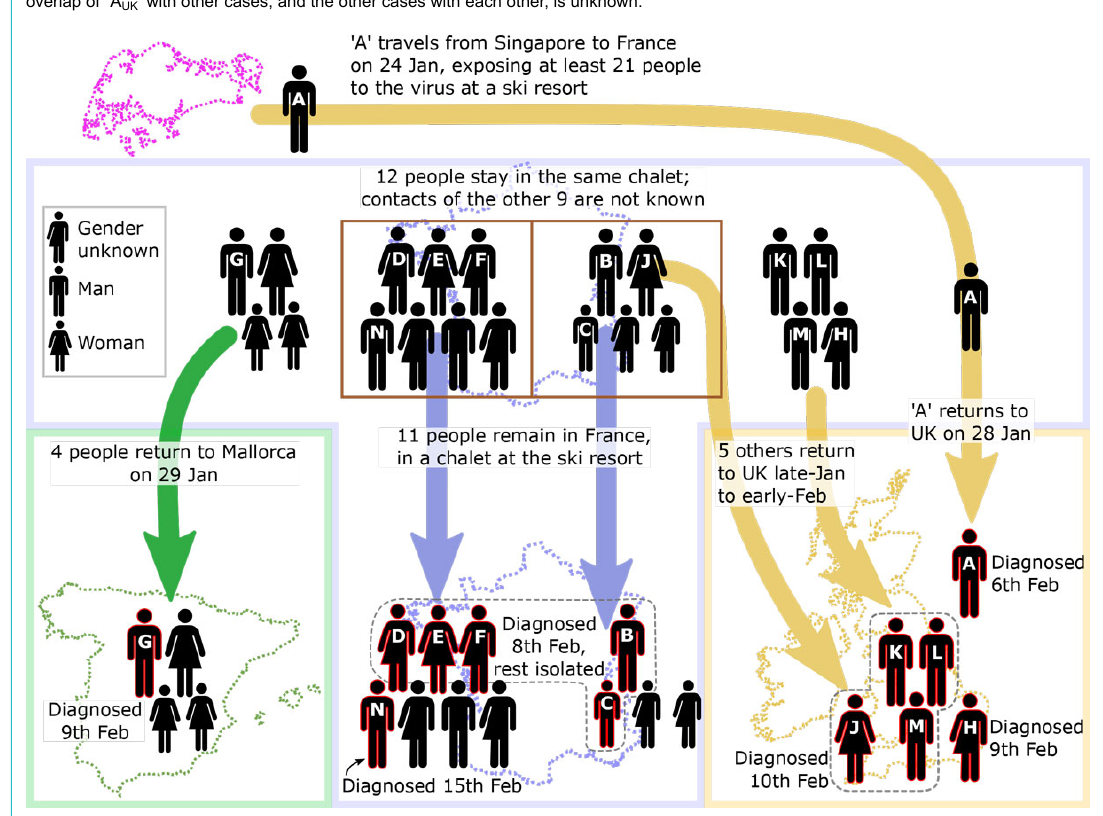
Figure 1: An overview of the “UK/France’ cluster shows the travel of the twenty-one people known to be involved, and the diagnosis dates of the 13 who eventually tested positive for SARS-CoV-2. Only the dates of when focal case “A UK ’ are in France are known definitely, and the overlap of “A UK ’ with other cases, and the other cases with each other, is